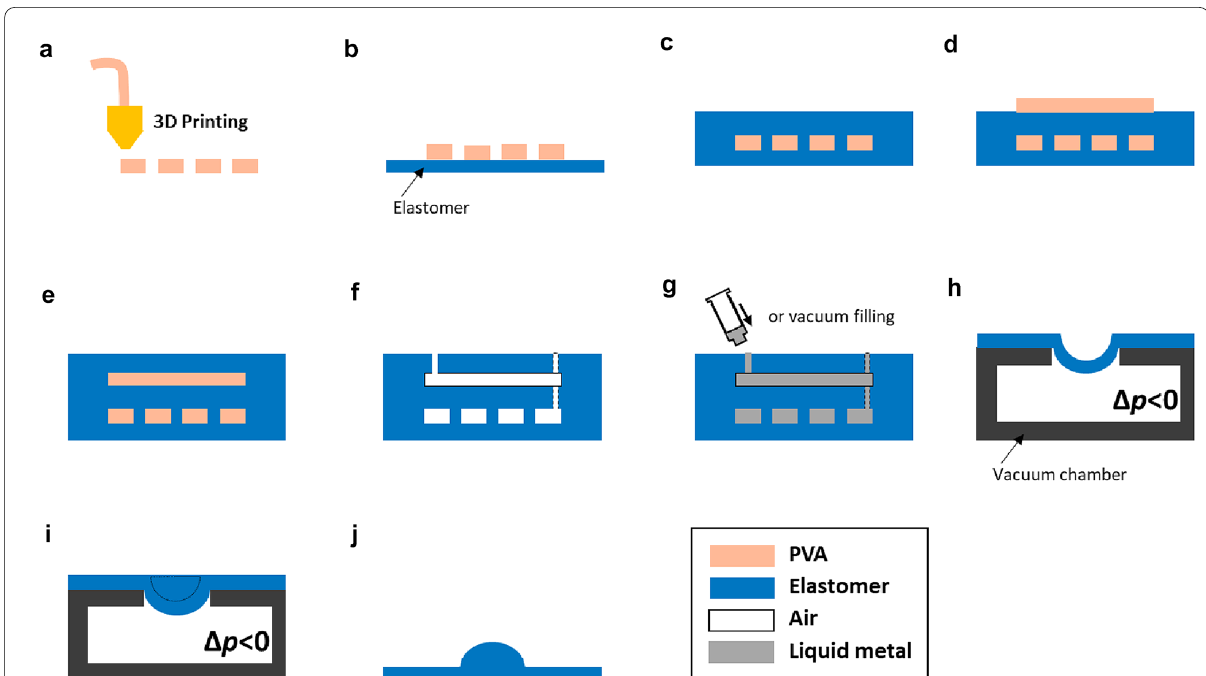
Fig. 3 Fabrication process of the proposed sensor. a 3D Printing of microchannel mold. b Placement of the 3D-printed PVA mold on the elastomer film. c Embedment of the mold by spin coating and curing. d Placement of the 2nd mold on the top. e Embedment of the mold. f Removal of the mold. g Filling of liquid metal inside microchannel using syringe injection or vacuum filling. h Fabrication of dome structure using the vacuum chamber. i Curing of additional elastomer for the fixation of dome structure. j Fabrication of the proposed